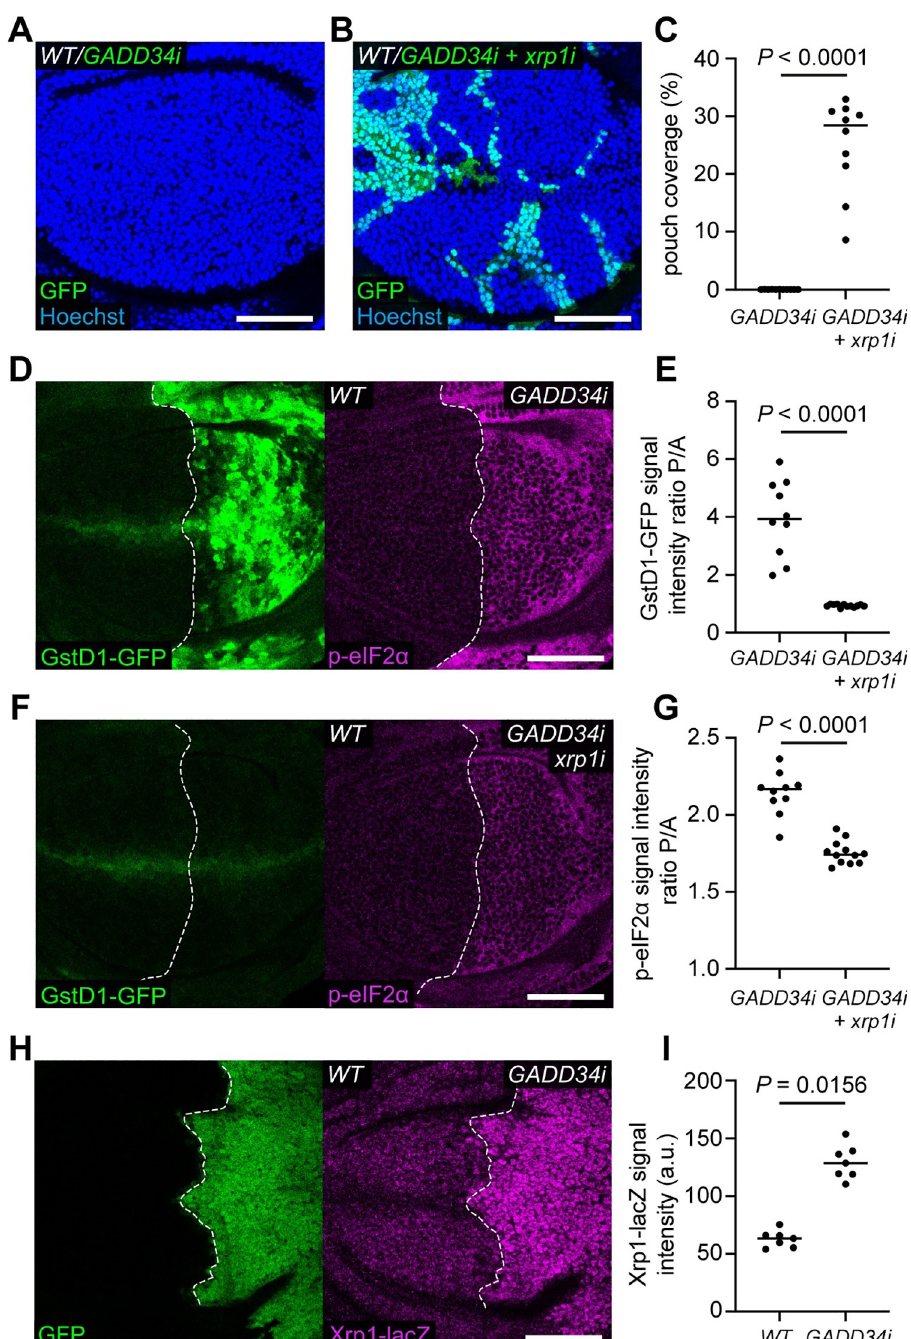
Fig 5. A feed-forward loop between Xrp1 and proteotoxic stress. ( A-C ) Wild-type wing discs harboring GADD34-RNAi ( GADD34i ) expressing cells (GFP positive) ( A ) or GADD34-RNAi and xrp1-RNAi ( xrp1i ) expressing cells (GFP positive) ( B ) with nuclei labelled in blue, and quantification of percentage coverage of the pouch ( C ) (n = 11 and 10, respectively; two-sided Mann–Whitney U-test). ( D-G ) Wing discs harboring GstD1-GFP (green) and expressing either GADD34-RNAi ( D ) or GADD34-RNAi and xrp1-RNAi ( F ) in the posterior compartment, immuno- stained for p-eIF2 α (magenta), with quantification of the Posterior / Anterior (P/A) ratio of GstD1-GFP signal intensity ( E ) (n = 10 and 12, respectively; two-sided Mann–Whitney U-test) and the Posterior / Anterior (P/A) ratio of p-eIF2 α signal intensity ( G ) (n = 10 and 12, respectively; two-sided Mann–Whitney U-test). ( H-I ) A wing disc carrying the xrp1-lacZ reporter and expressing GADD34-RNAi and GFP (green) in the posterior